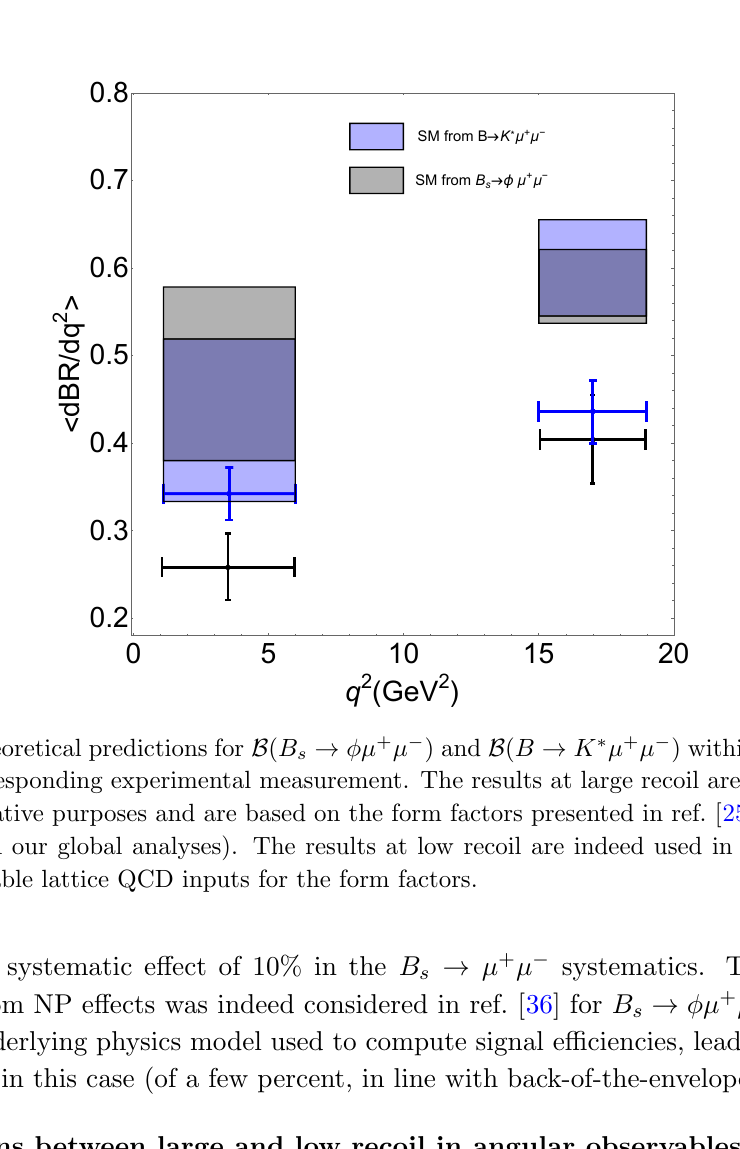
Figure 2. Theoretical predictions for with their corresponding experimental measurement. The results at large recoil are presented here only for illustrative purposes and are based on the form factors presented in ref. [25] (these results are not used in our global analyses). The results at low recoil are indeed used in ref. [6] and are based on available lattice QCD inputs for the form